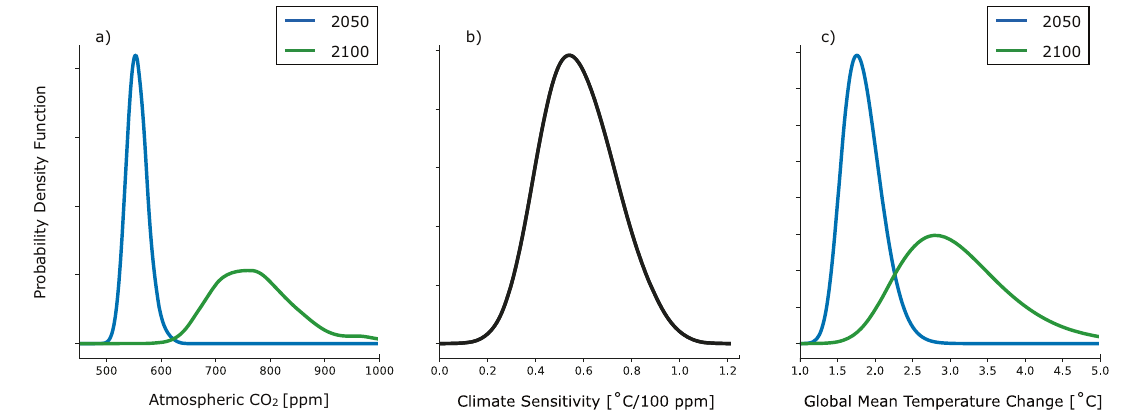
Fig. 1 Projections of CO 2 emissions and global mean temperature change through 2100. a shows probabilistic projections of atmospheric CO 2 concentrations in 2050 and 2100. b shows a probability distribution of transient global climate sensitivity written in terms of °C warming per 100 ppm of atmospheric CO 2 change. c shows the convolutions of the probability distributions in a , b , which yields a probability distribution of global mean temperature change (relative to the 1850 – 1900 baseline) in 2050 and